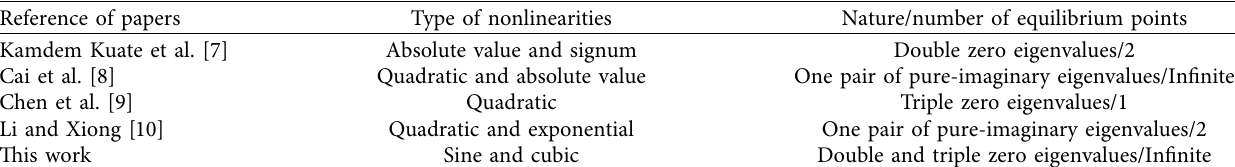
Table 1: Type of nonlinearities in non-Shilnikov chaotic systems with various nature of their